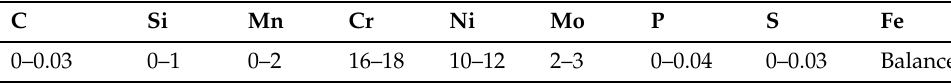
Table 1. Chemical composition of SS316L metal powder.